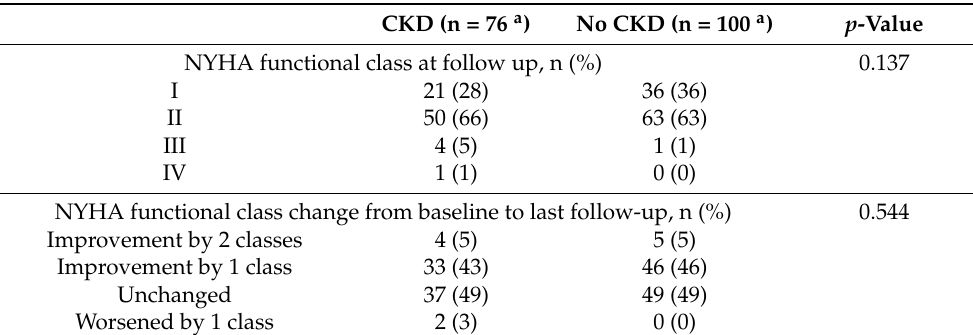
Table 3. Effect of treatment initiation with Sacubitril/Valsartan on NYHA functional class stratified by CKD at